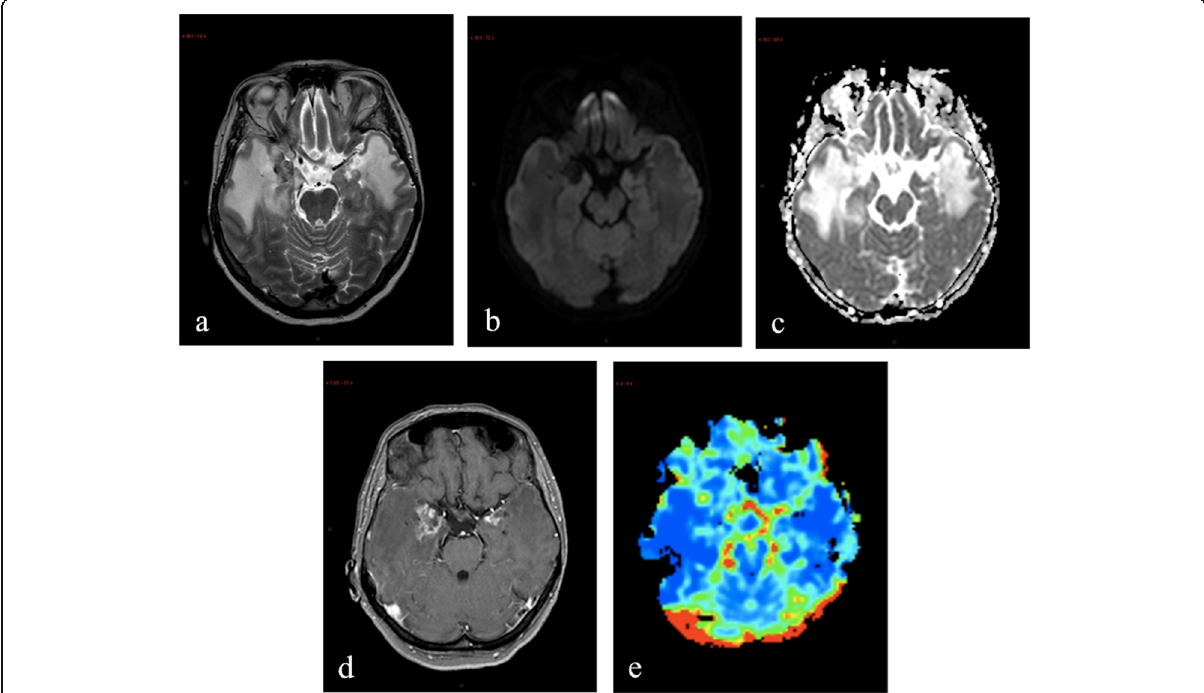
Fig. 8 MRI performed 22 months after 78.8 Gy carbon ion therapy in a Patient with malignant peripheral nerve sheath tumor. T2-weighted image ( a ) shows disomogeneous areas of altered signal, with hypo- and hyperintense components, located in mesial temporal regions both on the right and on the left, and surrounded by extensive edema involving subcortical polar and mesial temporal white matter. DWI documents no diffusion restriction within the enhancing areas with evident hyperintense areas in ADC map on both sides ( b, c ). Axial post contrast T1-weighted image ( d ) shows the presence of inhomogeneous contrast-enhancing lesions in mesial temporal regions both on the right and on the left. rCBV map ( e ) shows hyperperfusion of the left enhancing area and no hyperperfusion of the enhancing area on the